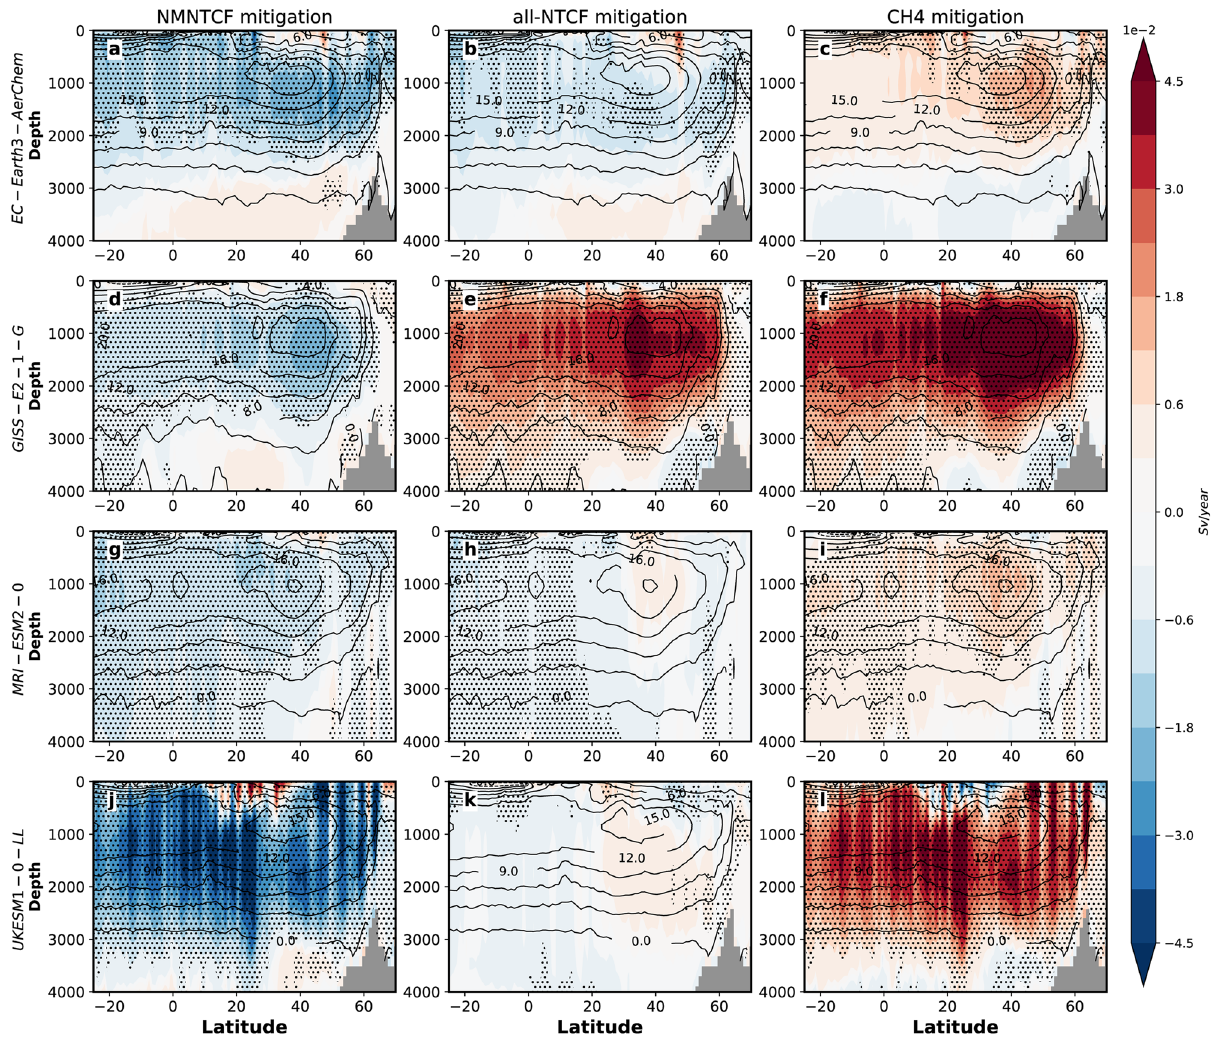
Fig. 1 2015 – 2100 annual mean depth-latitude trends in the Atlantic meridional stream function for the three mitigation signals. a , d , g , j NMNTCF, b , e , h , k all-NTCF, and c , f , i , l CH 4 mitigation for a – c EC-Earth3-AerChem, d – f GISS-E2-1-G, (g-i) MRI-ESM2-0, and j – l UKESM1-0-LL. Trend units are 10 − 2 Sverdrups yr − 1 , where Sverdrups (Sv) = 10 6 m 3 s − 1 . Symbols designate trend signi fi cance at 95% con fi dence level based on a standard t -test. Strengthening of the circulation is represented by red shading; weakening is represented by blue shading. Thin black lines show the 2015 – 2019 AMOC climatology based on the weak AQ control